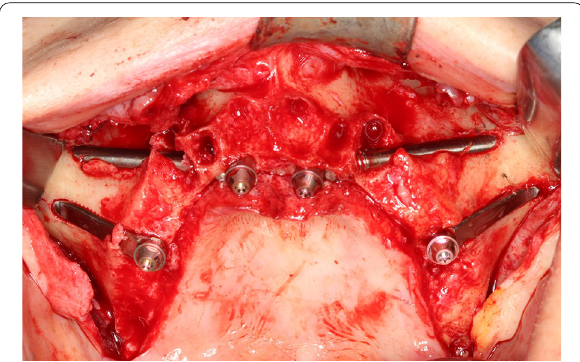
Fig. 8 Occlusal view after the installation of two Straumann ZAGA‑Round zygomatic implants on the anterior maxilla and two Straumann ZAGA‑Flat implants on the premolar zone. Note that the ZAGA‑Round implant is used to close a circular tunnel osteotomy; this is why the implant head is placed on the palatal side of the remaining crest. When it comes to the ZAGA‑Flat design the implant head is located right on the middle of the crest